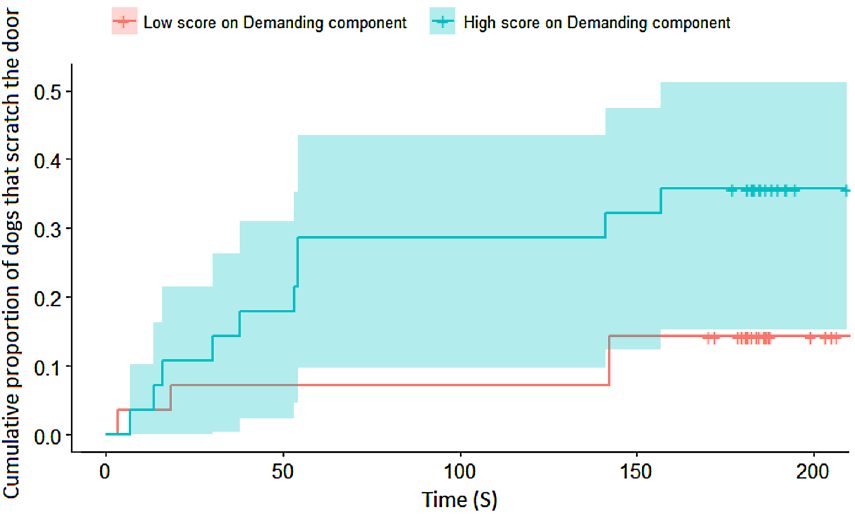
Figure 4. Differences based on the ‘Demanding’ component in the probability of scratching the door during the separation